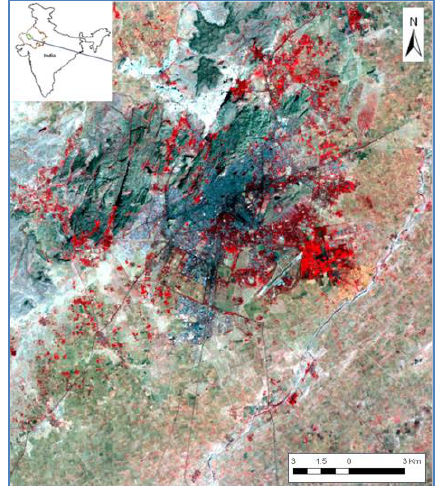
Figure 1. Satellite Image of Study